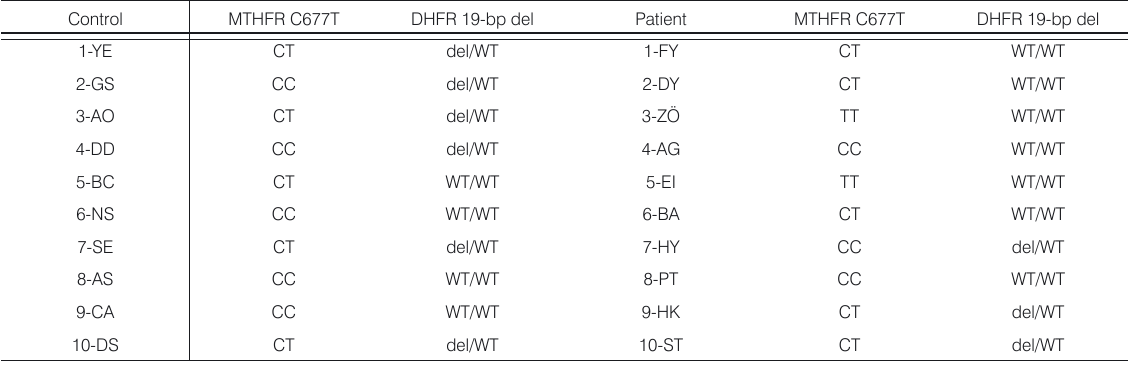
Table 1. The distributions of MTHFR C677T and DHFR 19-bp deletion polymorphism in control and in breast cancer